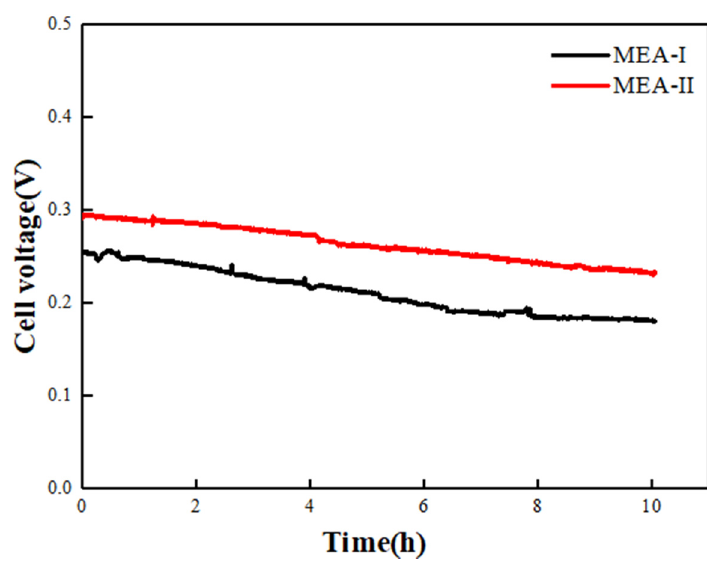
Figure 8. Stability testing curves of DMFCs. Testing condition of the DMFCs: methanol concentration, 2 M; temperature, 60 °C; discharging current density, 100 mA cm − 2 .